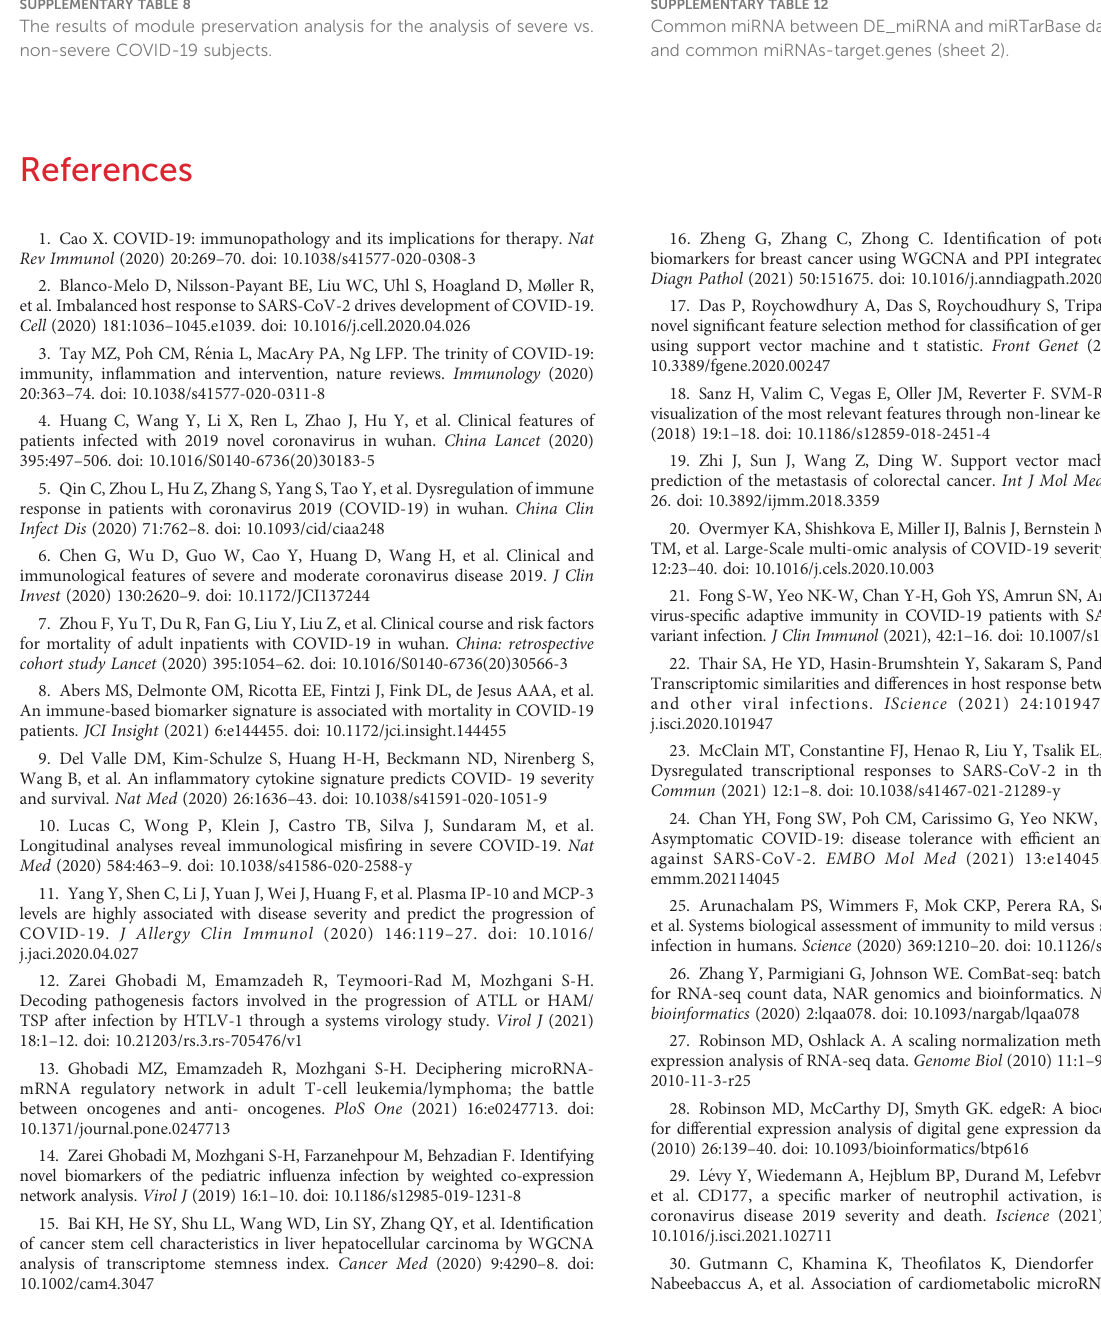
SUPPLEMENTARY TABLE 10 Common genes between co-expressed genes in Smodules and DEGs (DE_Smodules) (severe and non-severe modules). SUPPLEMENTARY TABLE 11 List of differentially expressed miRNA between severe and non- severe subjects. SUPPLEMENTARY TABLE 12 Common miRNA between DE_miRNA and miRTarBase database (sheet 1) and common miRNAs-target.genes (sheet